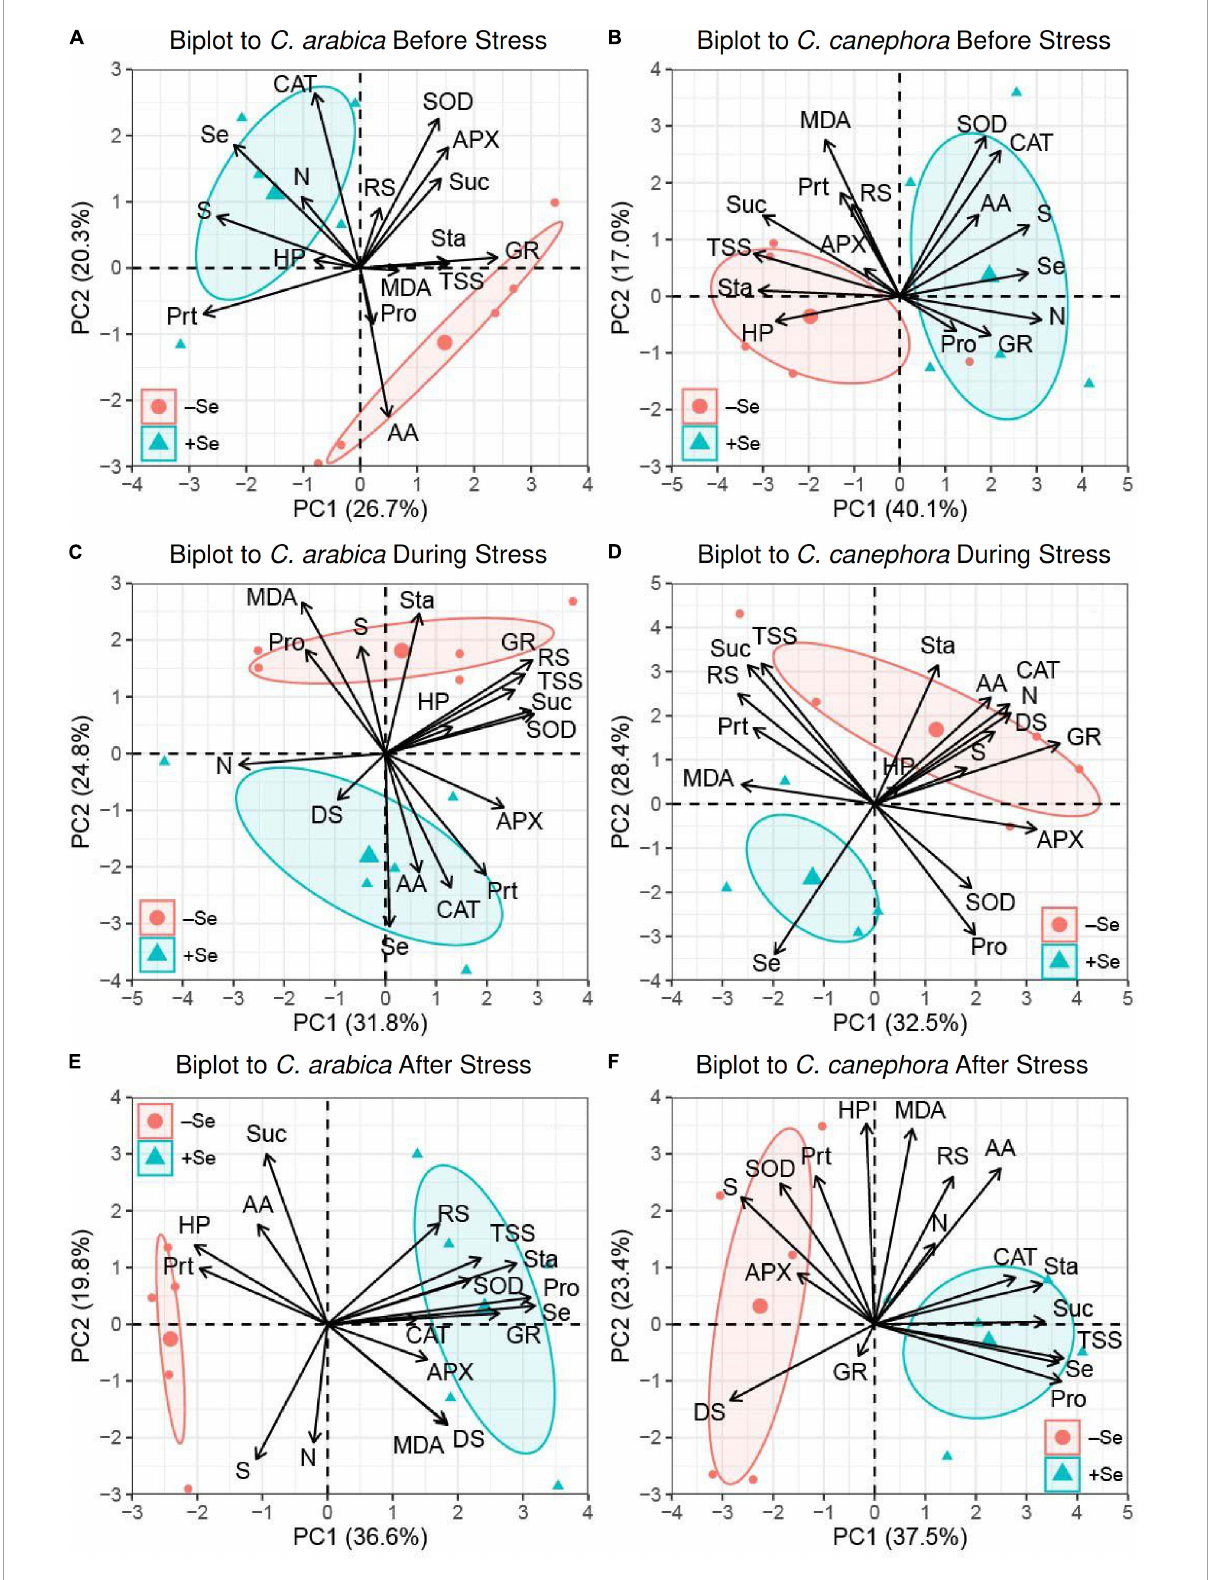
FIGURE6 PCAs biplot representation of leaves composition data before, during, and after chilling stress in two species. (A,C,E) C. arabica before, during, and after stress, respectively; (B,D,F) C. canephora before, during, and after stress, respectively.